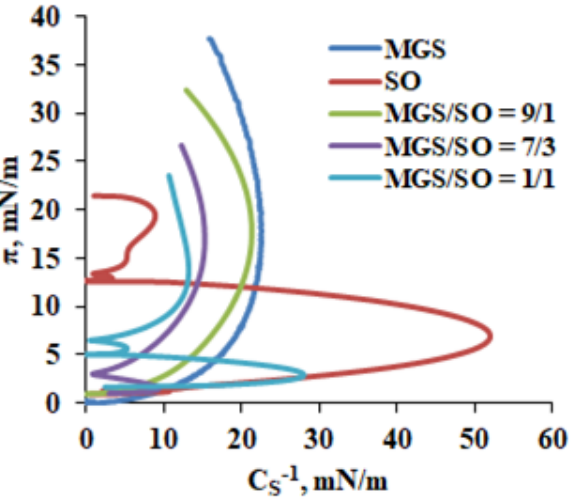
Figure 3. Dependence of the reciprocal compressibility (or rigidity) modulus on the surface pressure of the MGS/SO layers.